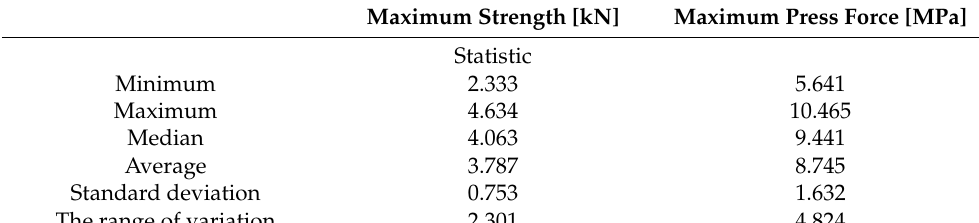
Table 11. Flexural strength tests for basalt dust A for all samples for water − mix ratio = 0.5.